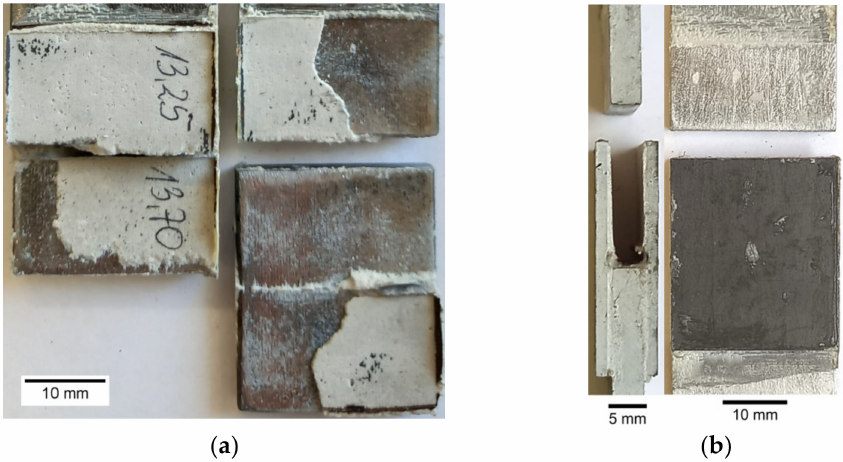
Figure 10. Failure forms of adhesive joints: ( a ) sample no. 1—steel overlays; ( b ) sample no. 11—S&P C-Laminate 150/2000